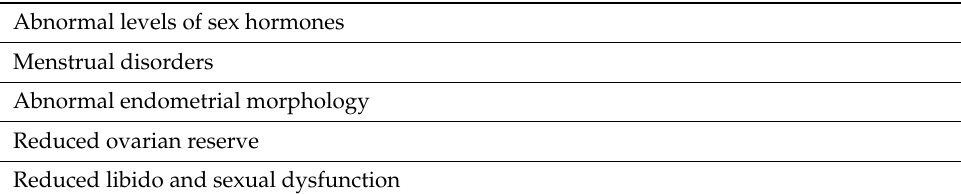
Table 3. Factors responsible for the reduced fertility in women with